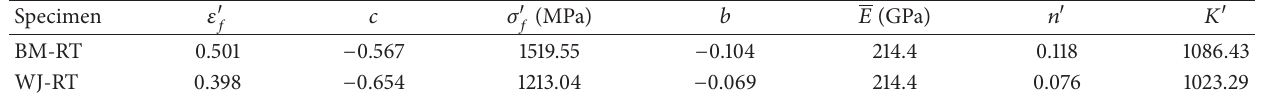
Table 4: Coefficients and exponents for regression analysis of the BM and WJ.